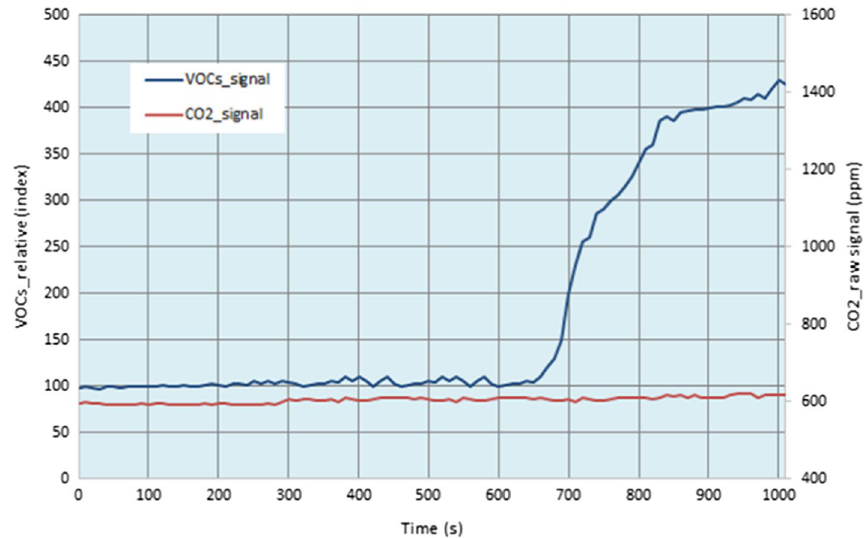
Fig. 20 Pilot 4: IAQ output signals of a malodour